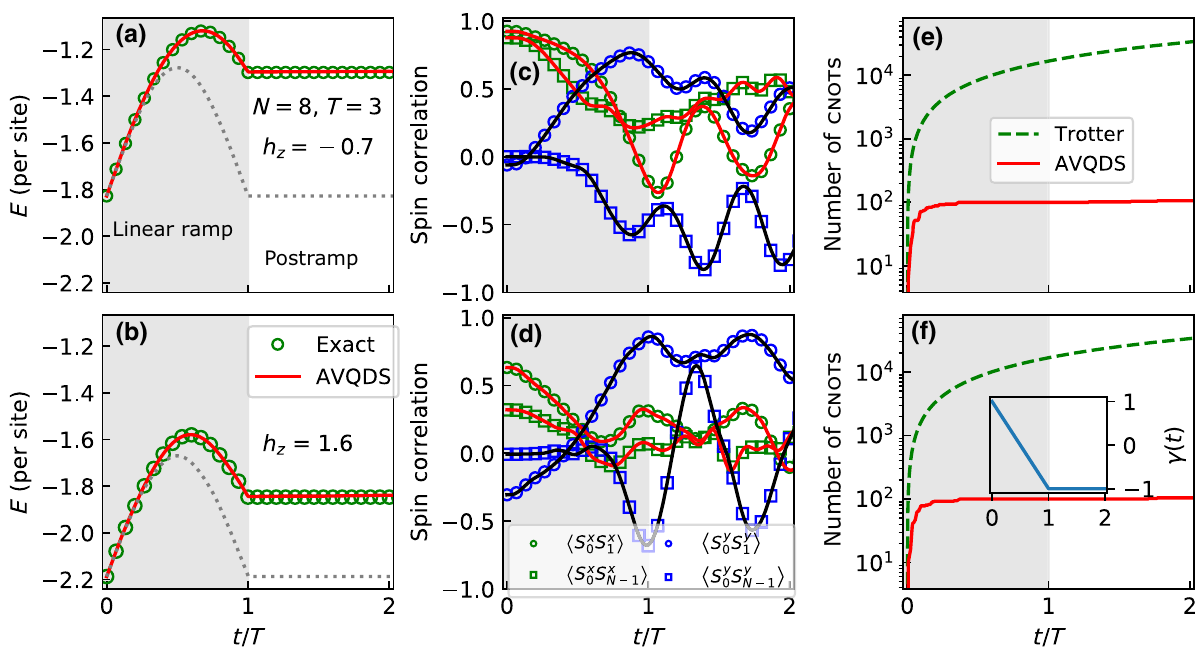
FIG. 4. Variations of instantaneous total energy, spin correlations, and number of two-qubit gates for quantum-quench simulations of the eight-site LSM chain model with open boundary conditions. The simulation is composed of a linear ramp with speed defined by T = 3, and postramp dynamics for another period of T . The results for h z = − 0.7 sites are shown in the upper panels, and that for h z = 1.6 in the lower panels. The exact results are shown in symbols, and AVQDS data in solid curves. The evolution of the instantaneous energy from numerically exact calculations and AVQDS is shown in (a),(b), along with the adiabatic results plotted as gray dotted lines for reference. The spin correlation function in (c),(d) includes xx and yy components for a pair of the first and second site and a pair of the first and last site. Compared with linear circuit growth of Trotter dynamics simulations, AVQDS circuits are much shallower, with a sublinear circuit growth rate that quickly decreases, as plotted in (e),(f). The ansatz at t = T is composed of 50 two-qubit Pauli rotation gates (100 CNOT s) for both cases, which slightly increases to 53 two-qubit gates at t = 2 T . A multiplying factor of 2 for CNOT gates is included, since each two-qubit Pauli rotation gate can be compiled to two CNOT s along with single-qubit gates assuming full connectivity [38]. Inset in (f): variation of Hamiltonian parameter γ as a function of t